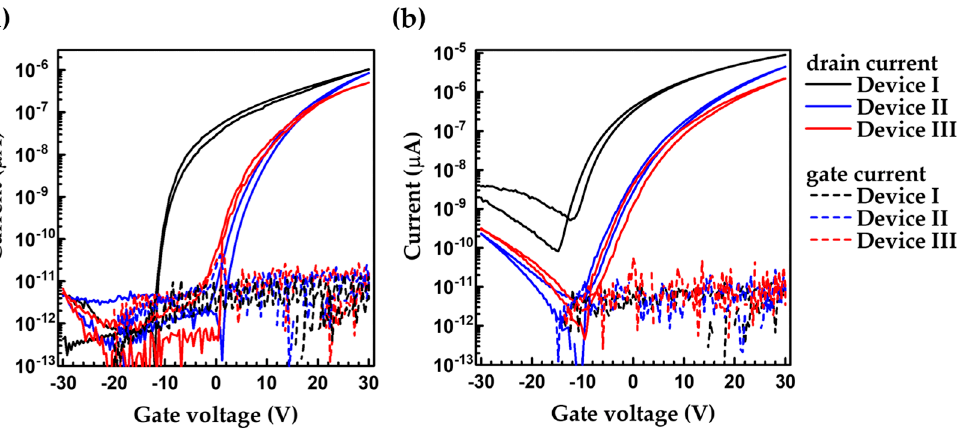
Figure 3. Transfer characteristics at ( a ) V DS = 5 V and ( b ) V DS = 30V. Solid lines are drain current and dashed lines are gate current.